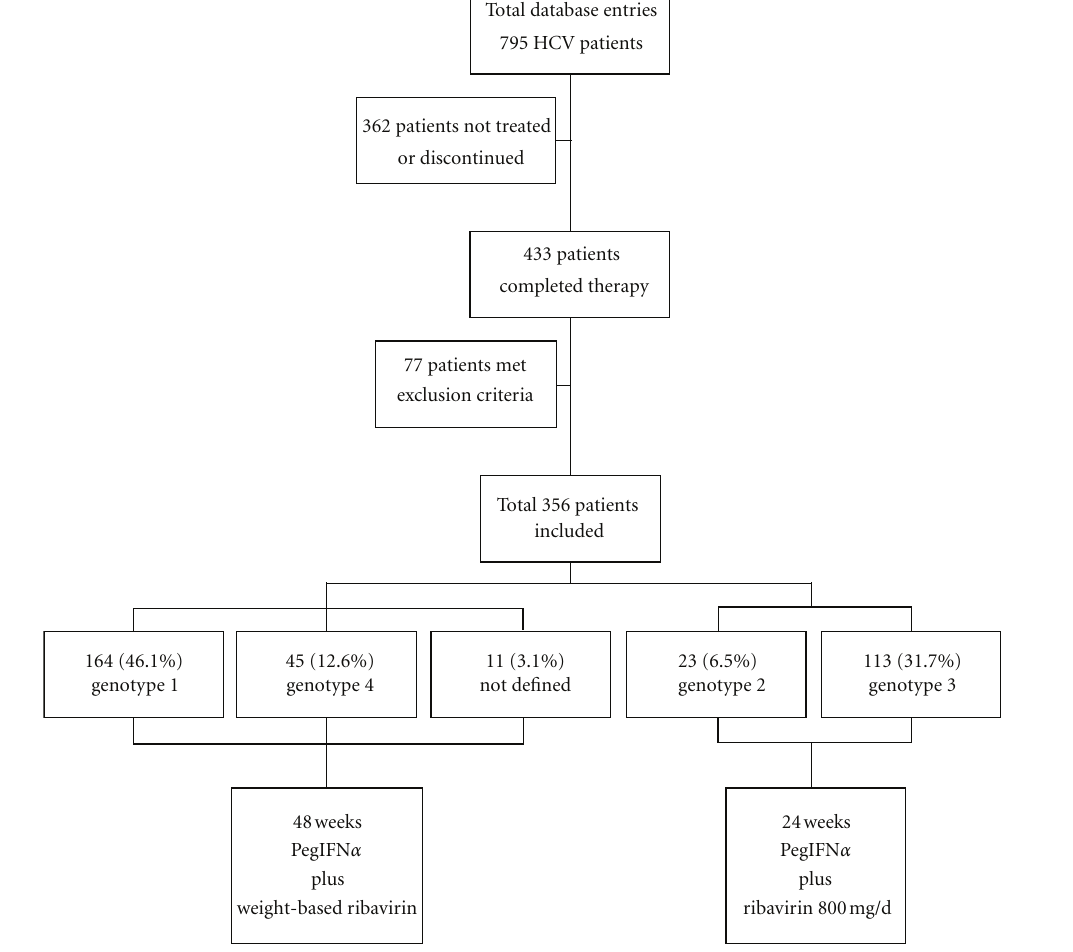
Figure 1: Patients entering the